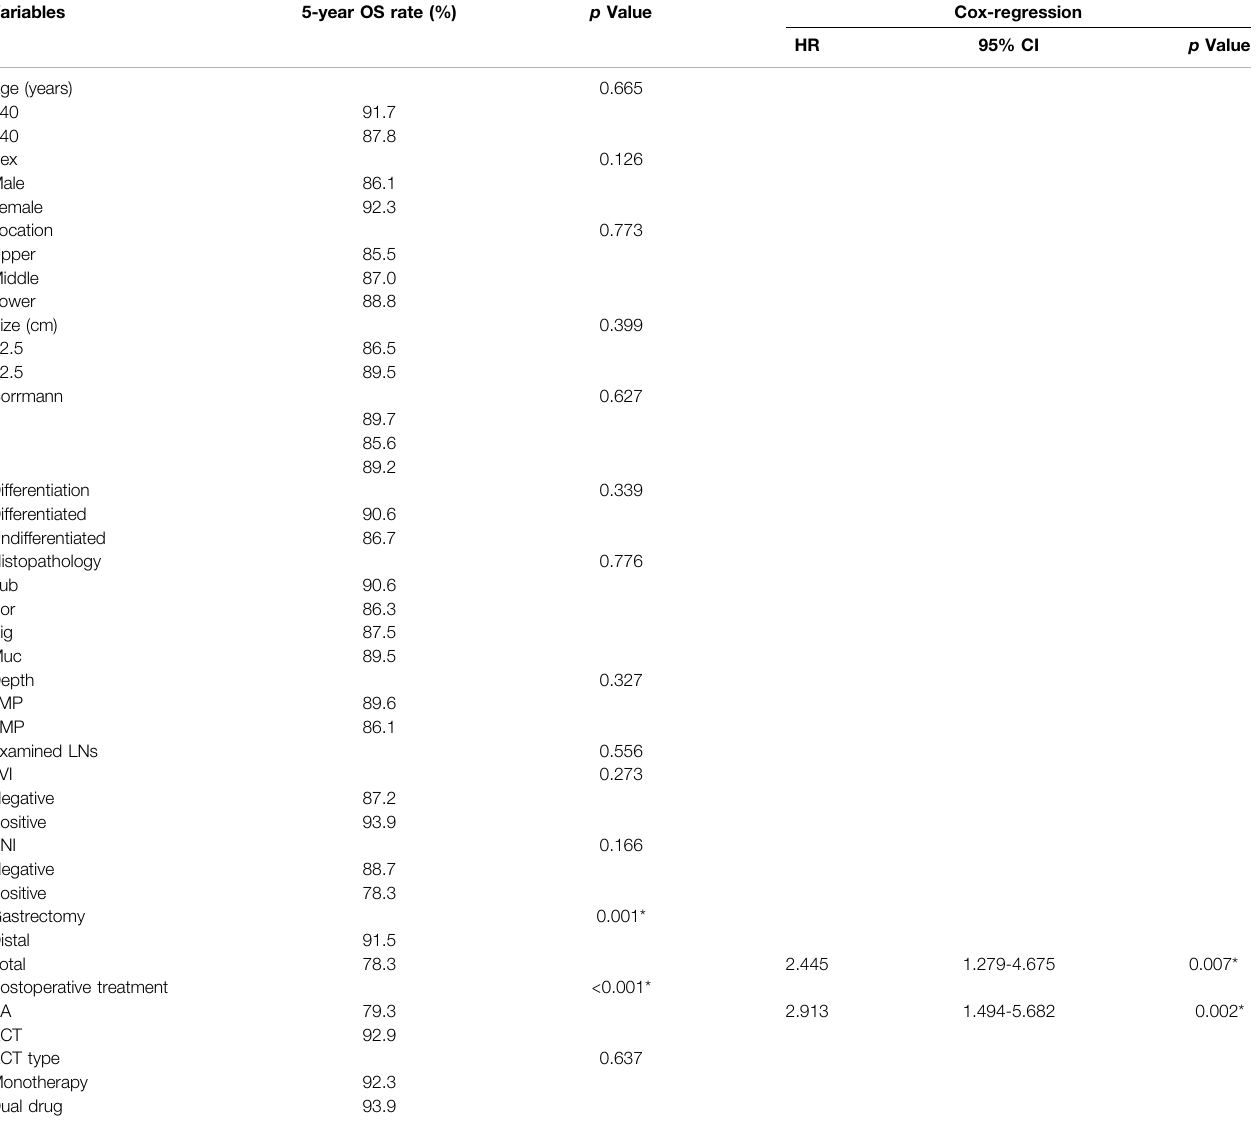
TABLE 2 | Univariate and Cox-regression of overall survival of patients with pT2N0M0 gastric cancer.